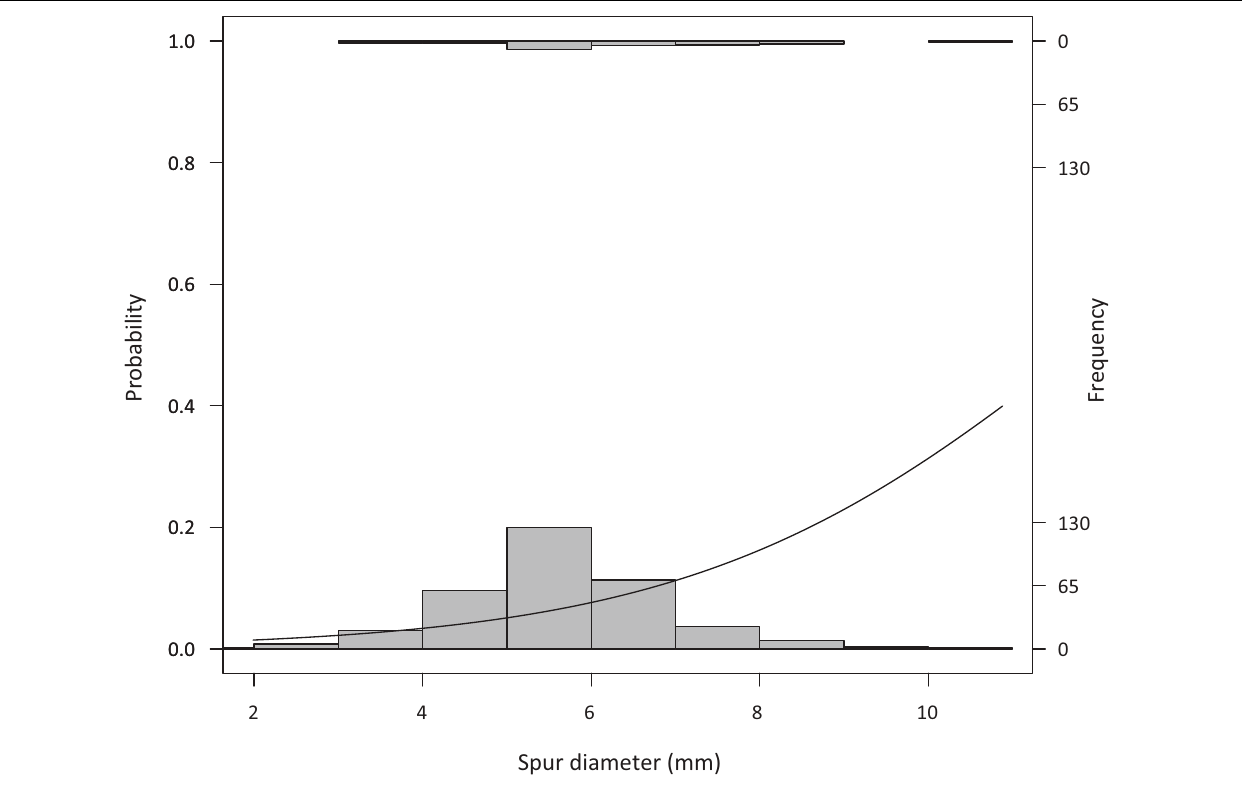
Frontiers in Environmental Science |